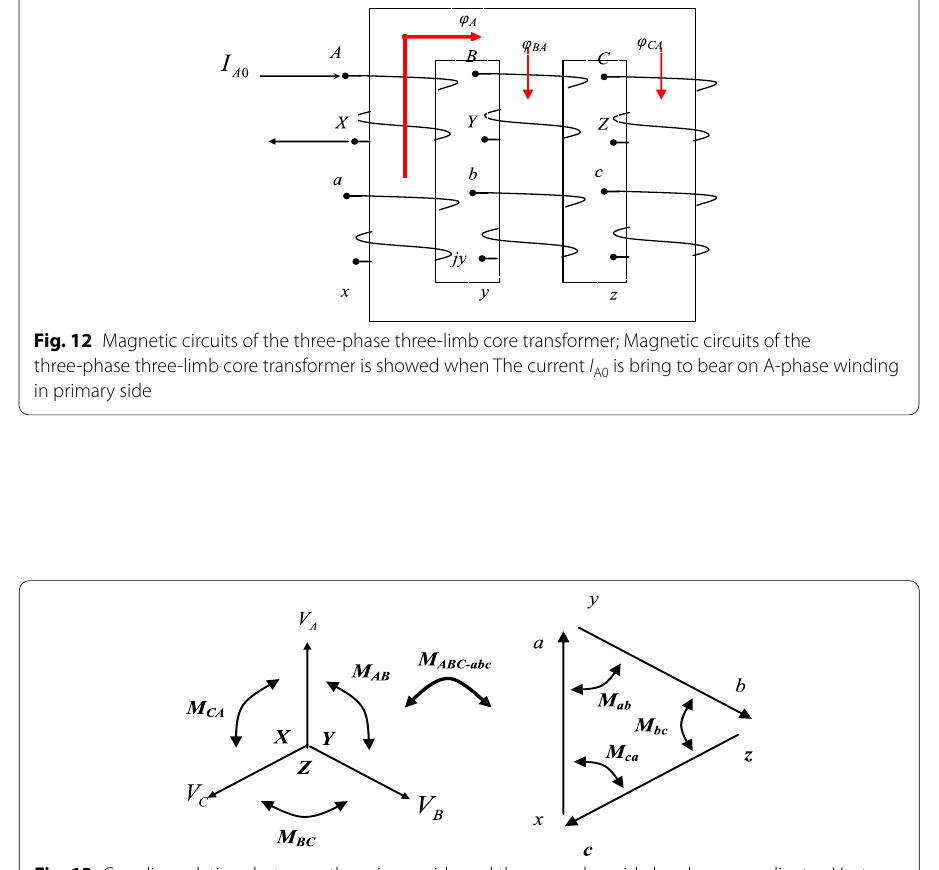
Fig. 13 Coupling relations between the primary side and the secondary side by phase-coordinates; Vector graph of the relationship between voltage and coupling is used to describe the Coupling relations between the primary side and the secondary side by